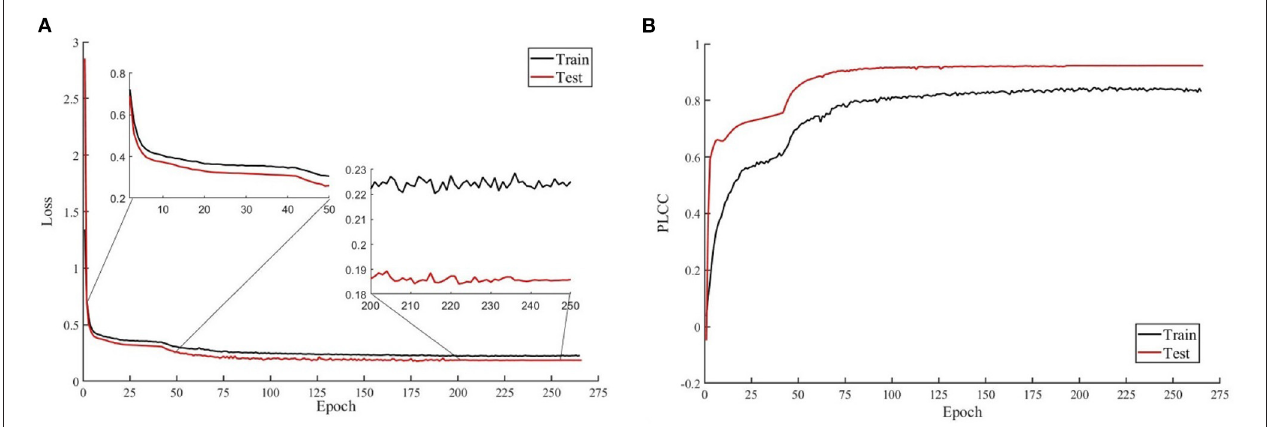
FIGURE 4 | Loss and Pearson’s linear correlation coefficient (PLCC) during training and test. (A) Loss of training and test. Two enlarged subfigures shows results of epochs 2–50 and epochs 200–250. (B) PLCC of training and test. The model is trained with recognition task on KonIQ-10k.